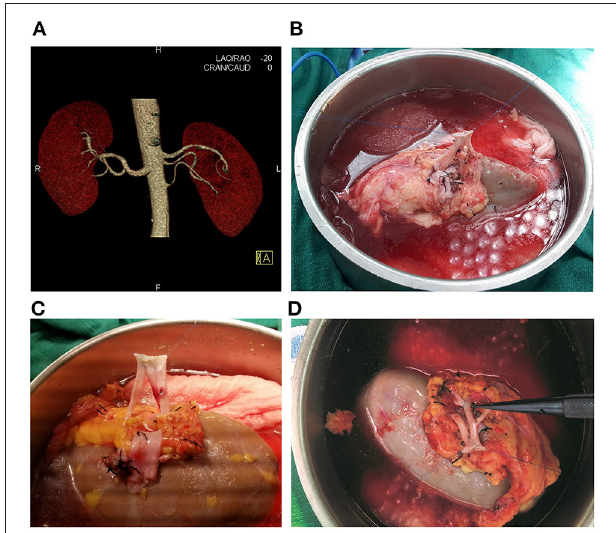
FIGURE 1 | (A) Computed Tomography Angiography showing the left kidney with three renal arteries. (B) Living donor kidney with two arteries, conjoined side-to side with 8-0 Prolene. (C) Living donor kidney with three arteries, with all three renal arteries conjoined side-to side with 8-0 Prolene. (D) Living donor kidney with two main renal arteries and an upper pole accessory renal artery. The two renal arteries were anastomosed side-to-side with 7-0 Prolene, and the accessory upper pole artery was anastomosed end-to-side into one of the main renal arteries with 8-0 Prolene suture inside the renal